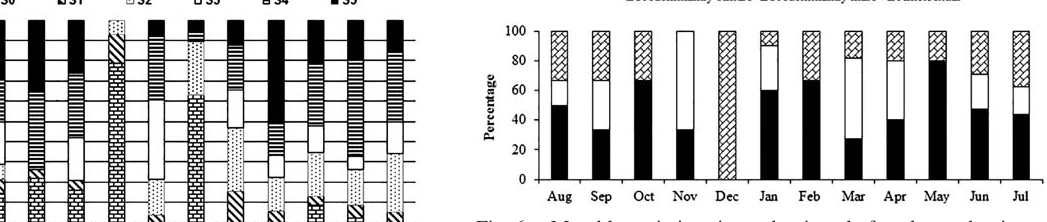
Fig. 6. – Monthly variations in predominantly female, predominant- ly male and ambisexual in hermaphrodite individuals from August 2008 to July 2009. Fig. 4. – Percentage of different stages in total population of Ostrea edulis from August 2008 to July 2009 (inactive (S0), early develop- ing (S1), developing (S2), ripe (S3), partly spawned (S4) and fully spawned (S5)).